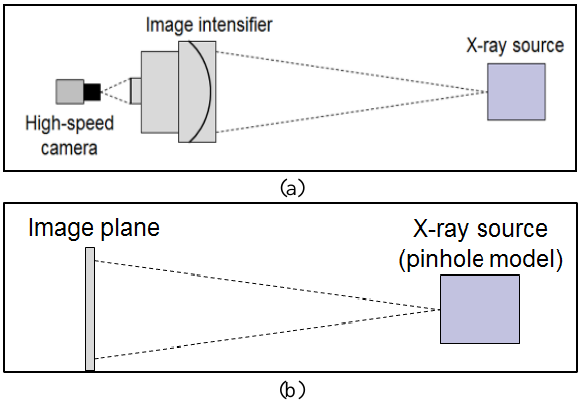
Figure 2. DF sensor model, (a) actual system configuration